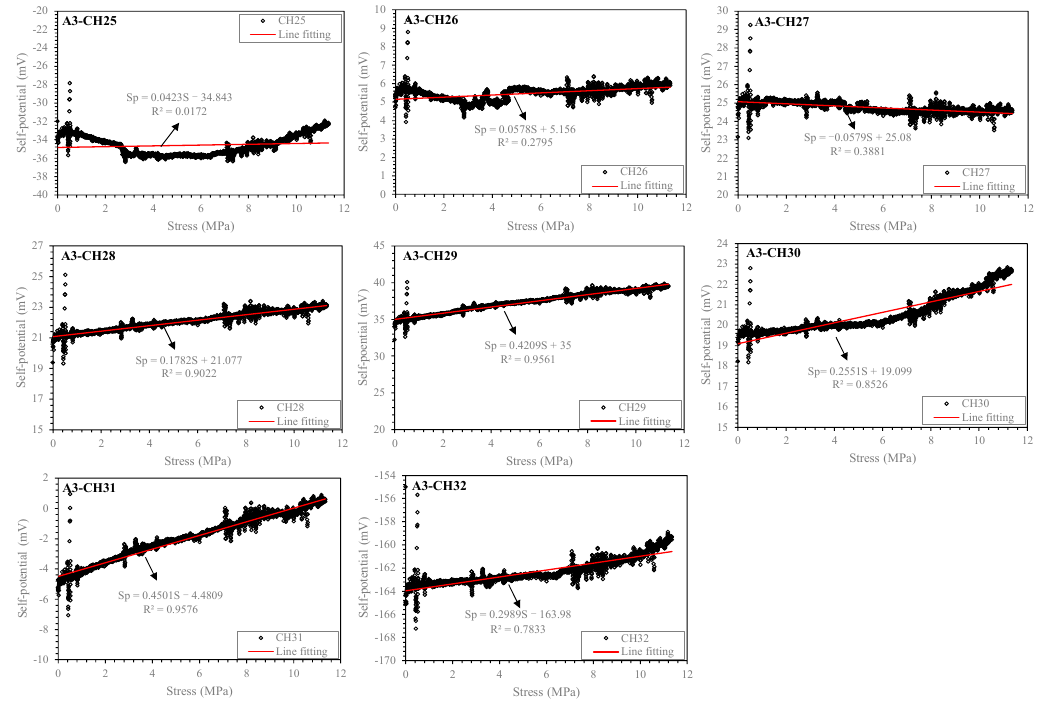
Figure 11. Scatter diagram of the relationship between self-potential and stress of bituminous coal sample A3 at the initial stage of uniaxial compression. Table 2. Correlation coefficient parameters of self-potential and stress of all studied bituminous coal samples.